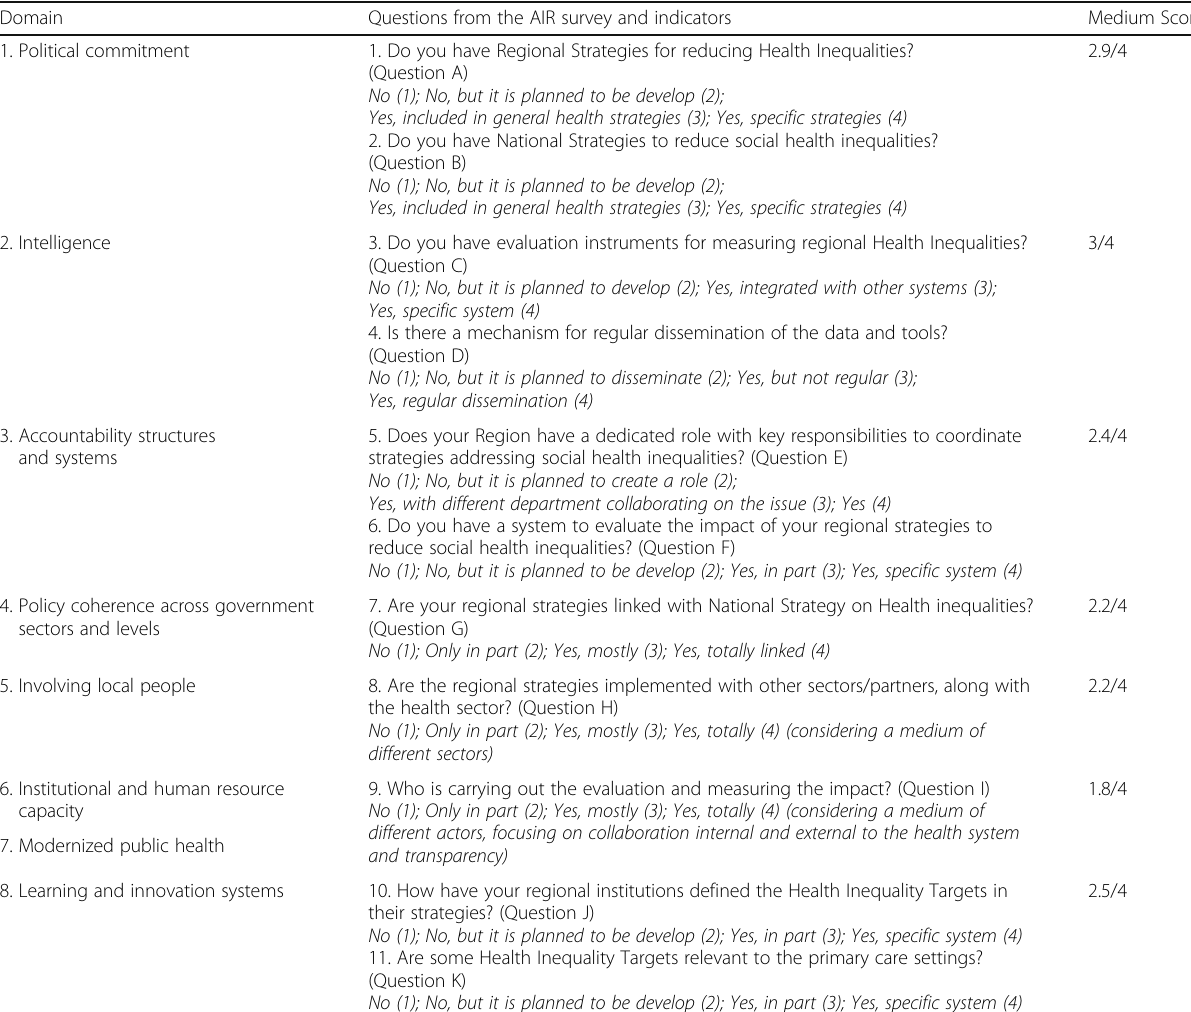
Table 3 Domains and questions from the AIR survey Domain Questions from the AIR survey and